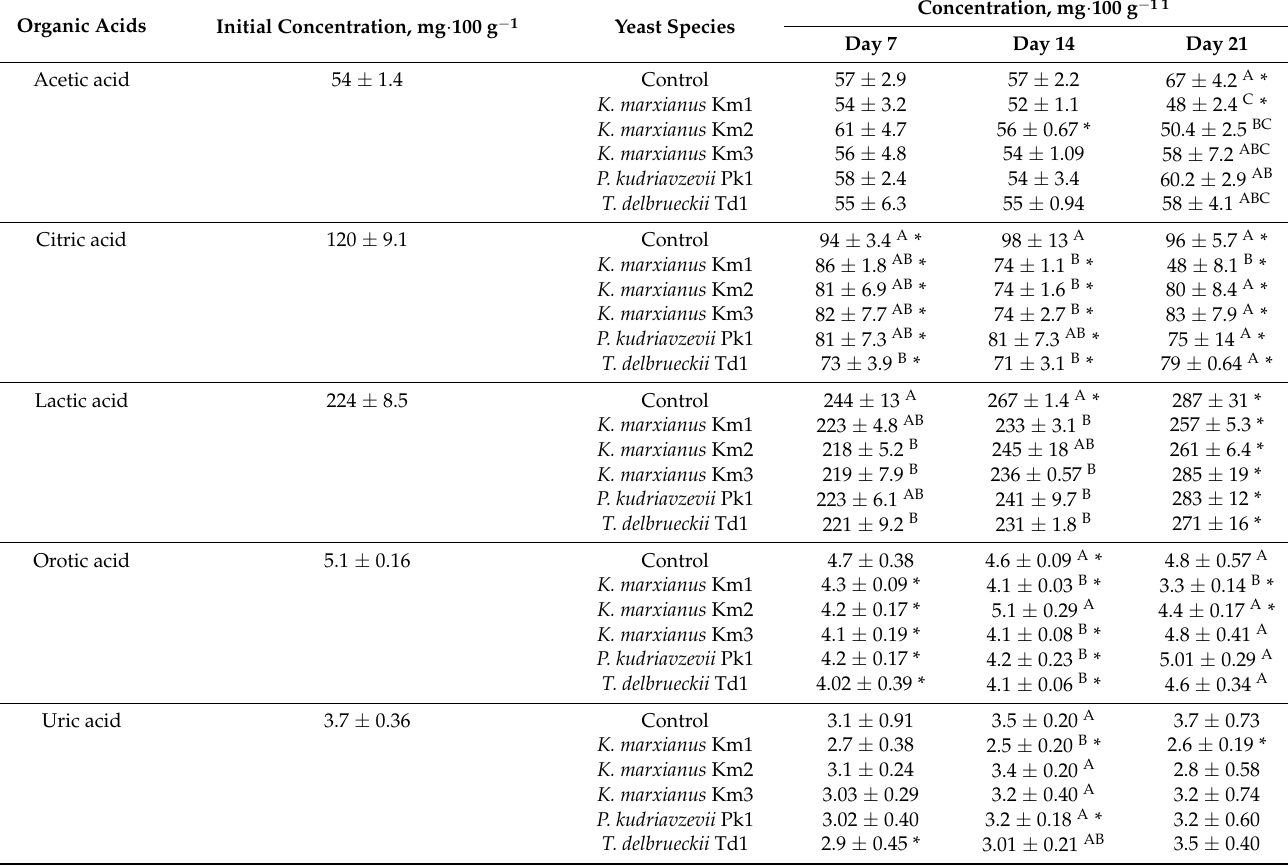
Table 3. Concentration of organic acids in skyr during yeast